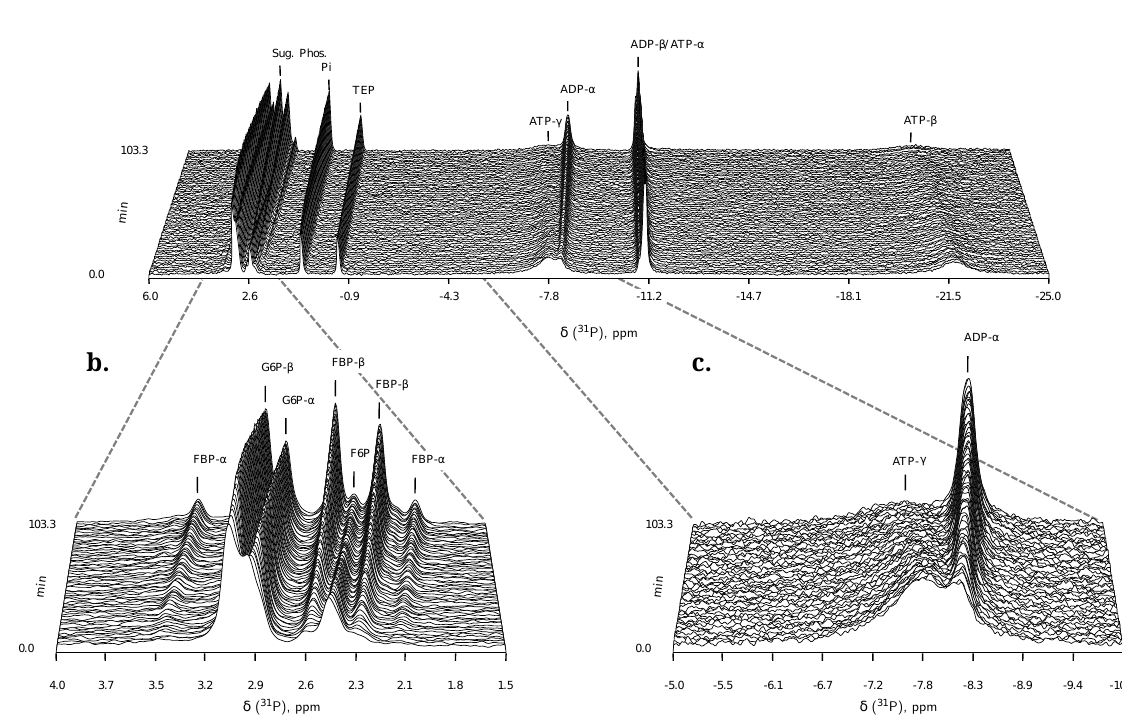
region (4.0 to 1.5 ppm); ( c ) Expansion of the nucleoside phosphate region ( − 5 to − 10